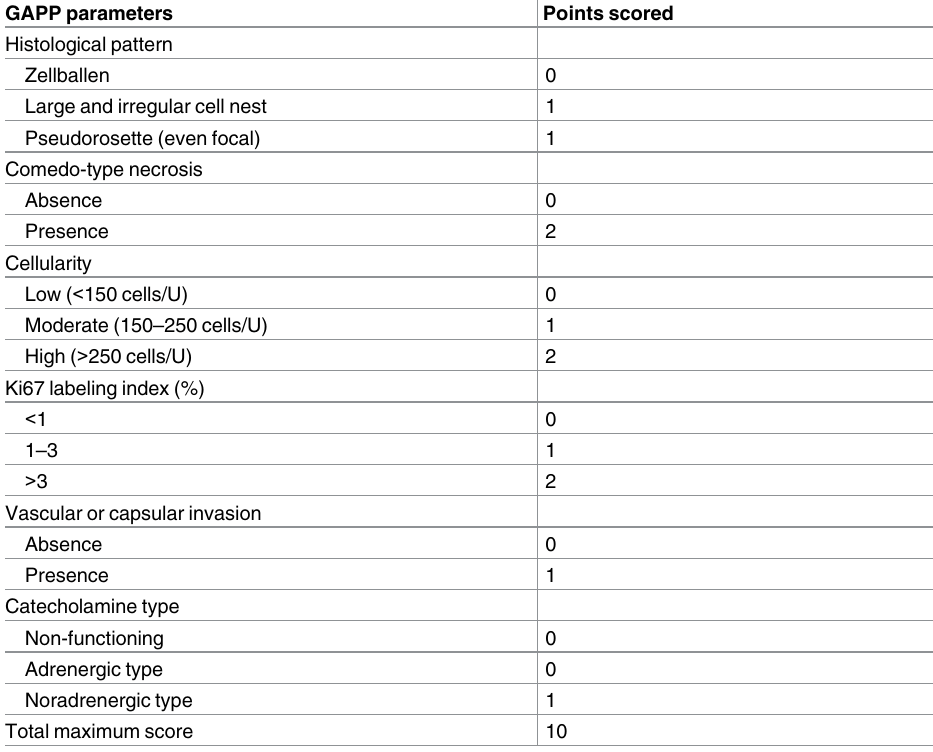
Table 1. Grading systemfor Adrenal Pheochromocytoma and Paraganglioma (GAPP).